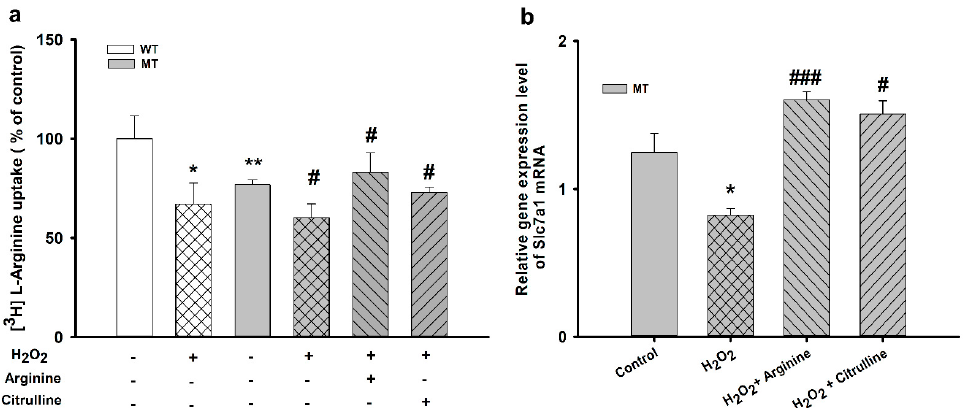
Figure 4. Pretreatment effect of oxidative stress-inducing H 2 O 2 on [ 3 H]L-arginine uptake by ALS cell lines . ALS cell lines were exposed to 100 µ M H 2 O 2 for 24 h. ( a ) [ 3 H]L-Arginine uptake was measured at pH 7.4 and 37 °C for 5 min in WT and MT cell lines pretreated with H 2 O 2 with or without treatment with 10 mM L-arginine and L-citrulline. ( b ) mRNA expression level of Slc7a1 in the MT cell line. Each value represents the mean ± SEM ( n = 3–4). * p < 0.05, ** p < 0.01, significant differences vs. control; # p < 0.05, ### p < 0.001, vs. H 2 O 2 treatment. H 2 O 2 significantly decreased [ 3 H]L-arginine uptake in both cell lines compared with that in control. Additionally, 10 mM of arginine and citrulline increased [ 3 H]L-arginine